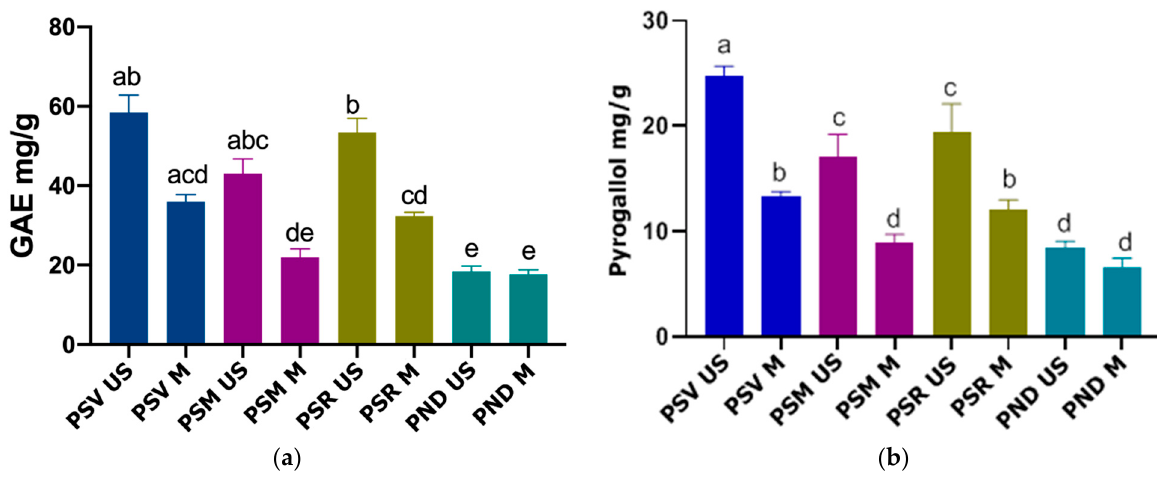
Figure 1. ( a ) Total polyphenol content (TPC) of the pine species bark extracts; ( b ) total tannin content (TTC) of the pine species bark extracts; different letters indicate significant differences; PSV US— P. sylvestris (Vama) extract obtained by UAE; PSV M— P. sylvestris (Vama) extract obtained by MAE; PSM US— P. sylvestris (Media ș ) extract obtained by UAE; PSM M— P. sylvestris (Media ș ) extract obtained by MAE; PSR US— P. sylvestris (Reghin) extract obtained by UAE; PSR M— P. sylvestris obtained by MAE.